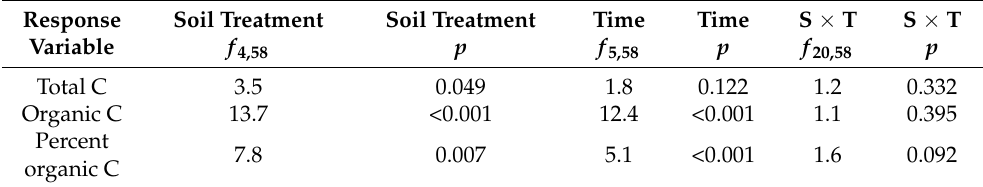
Table 1. Results from 5 soil treatment × 6 incubation time factorial ANOVA for soil carbon (C) variables. n =